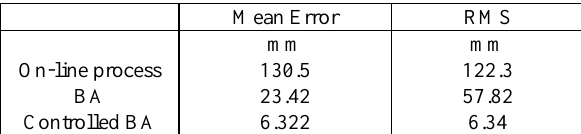
Table1. Mean Error and RMS of different method